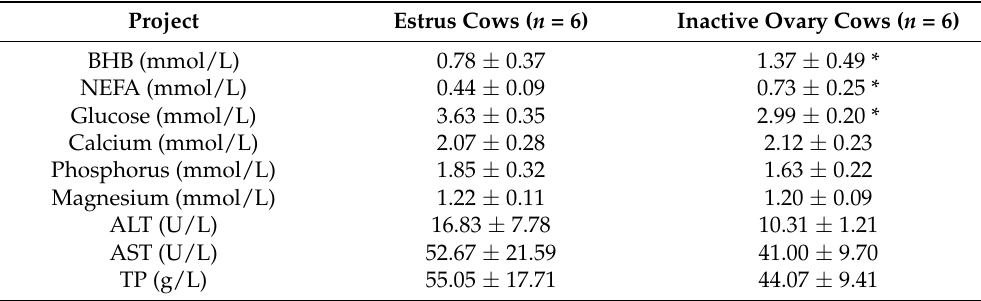
Table 3. Serum biochemical parameter levels in the two groups of tested